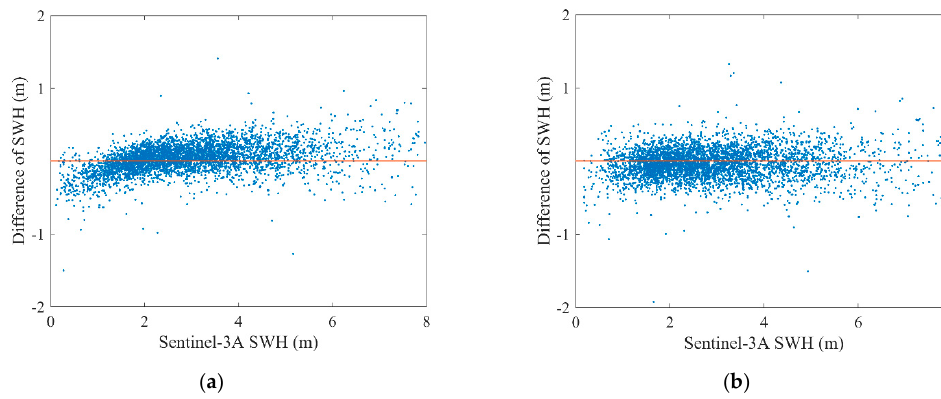
Figure 17. Dependence of SWH difference between Sentinel-3A ( a ) SAR and ( b ) PLRM modes SWH and Jason-3 at their dual-crossovers on the Sentinel-3A SWH.